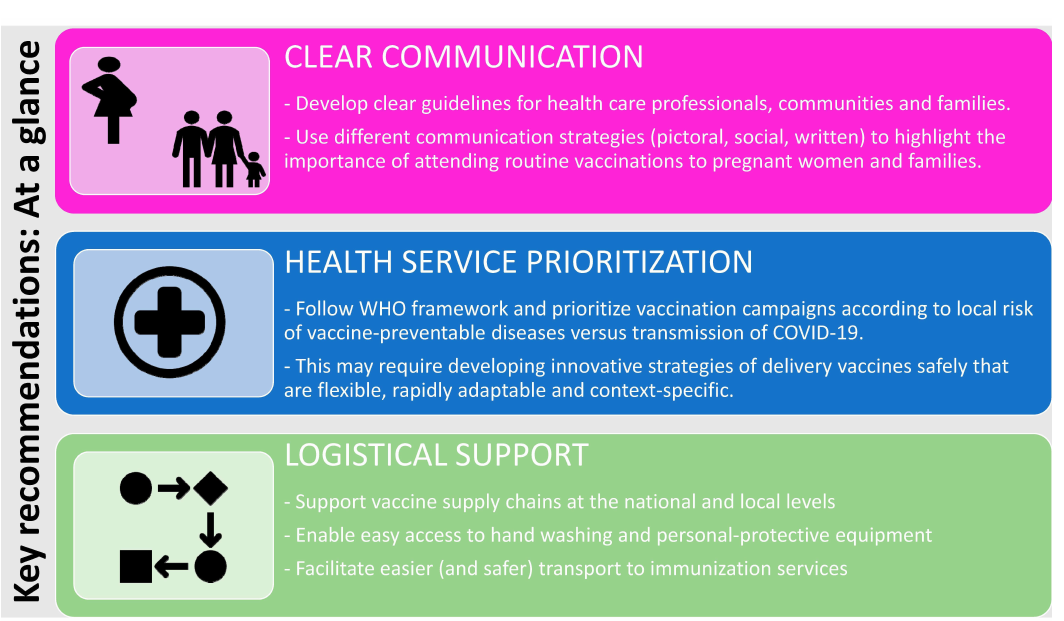
Figure 3. Key recommendations: At a glance. WHO: World Health Organization.